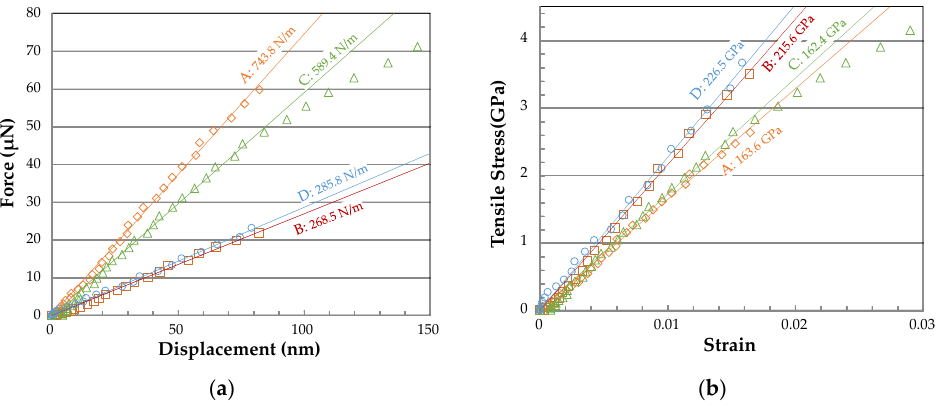
Figure 9. ( a ) Force–displacement plots and ( b ) tensile stress–strain plots. Lines indicates linear fittings. Note that fitting is done on a linear range (up to 80 nm displacement) for Specimen C.